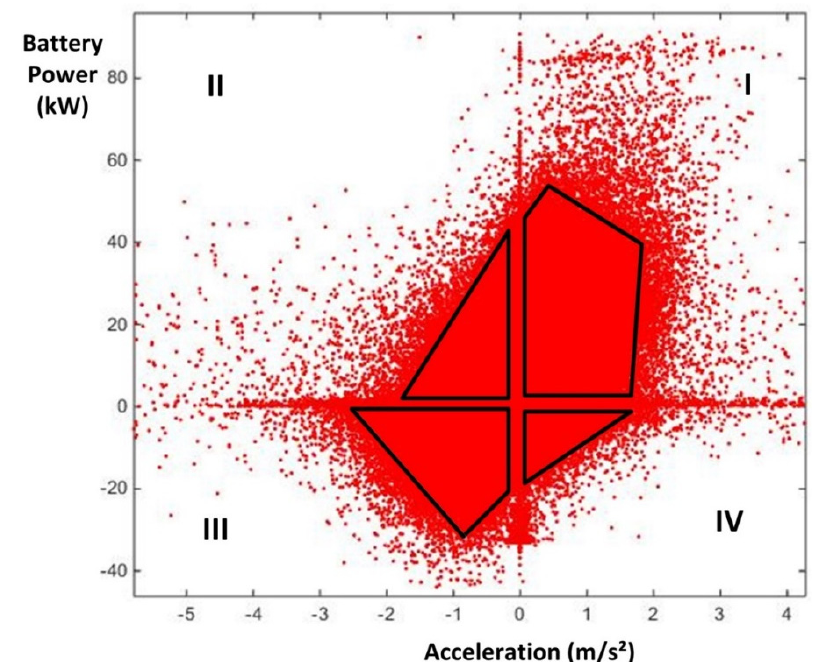
Figure 13. Four quadrant operation data points for the 2013